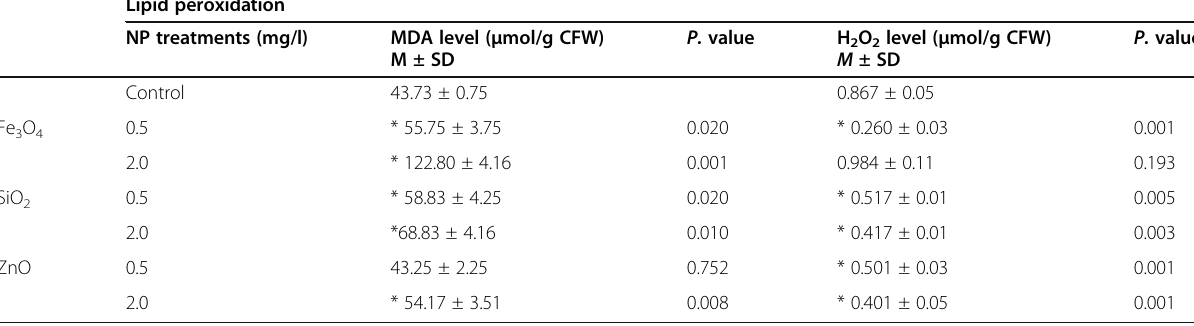
Table 3 Effect of nanoparticles on MDA and H 2 O 2 levels in Salvadora persica callus after 45 days of treatment Lipid peroxidation